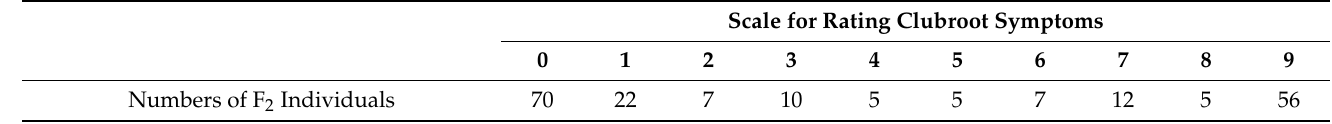
Table 1. Distribution of F 2 disease levels (disease index) after testing with Pbh of P. brassicae .